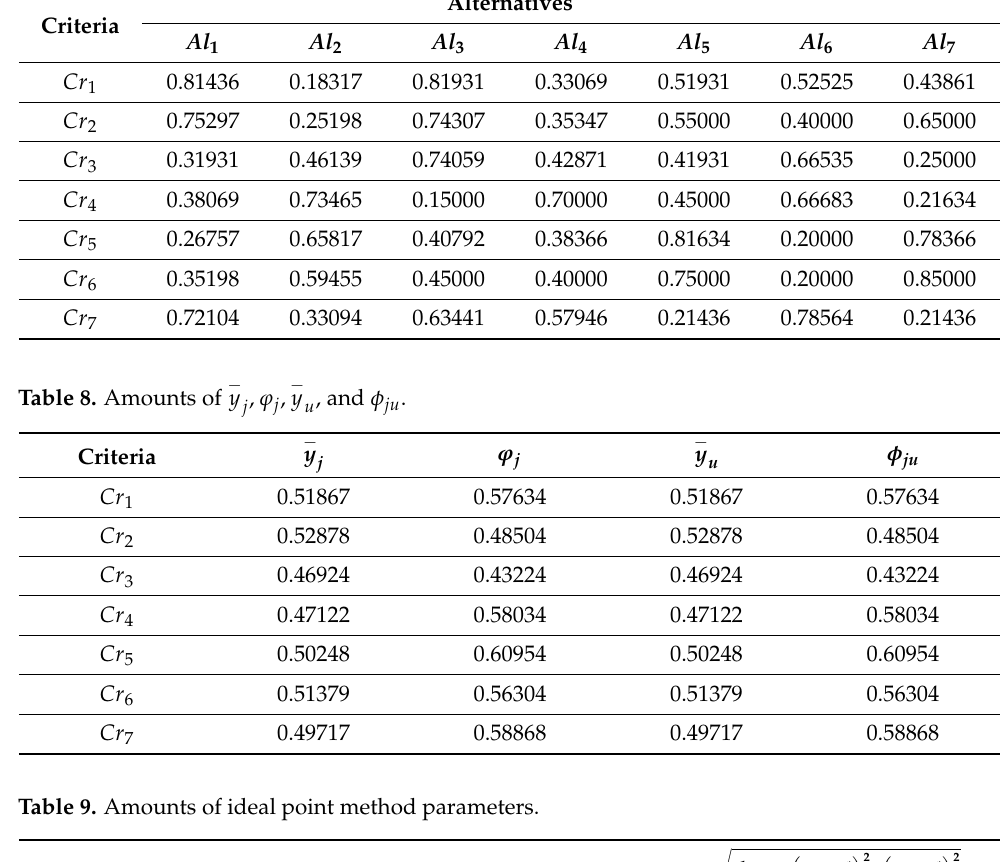
Table 7. Score of symmetric matrixes.